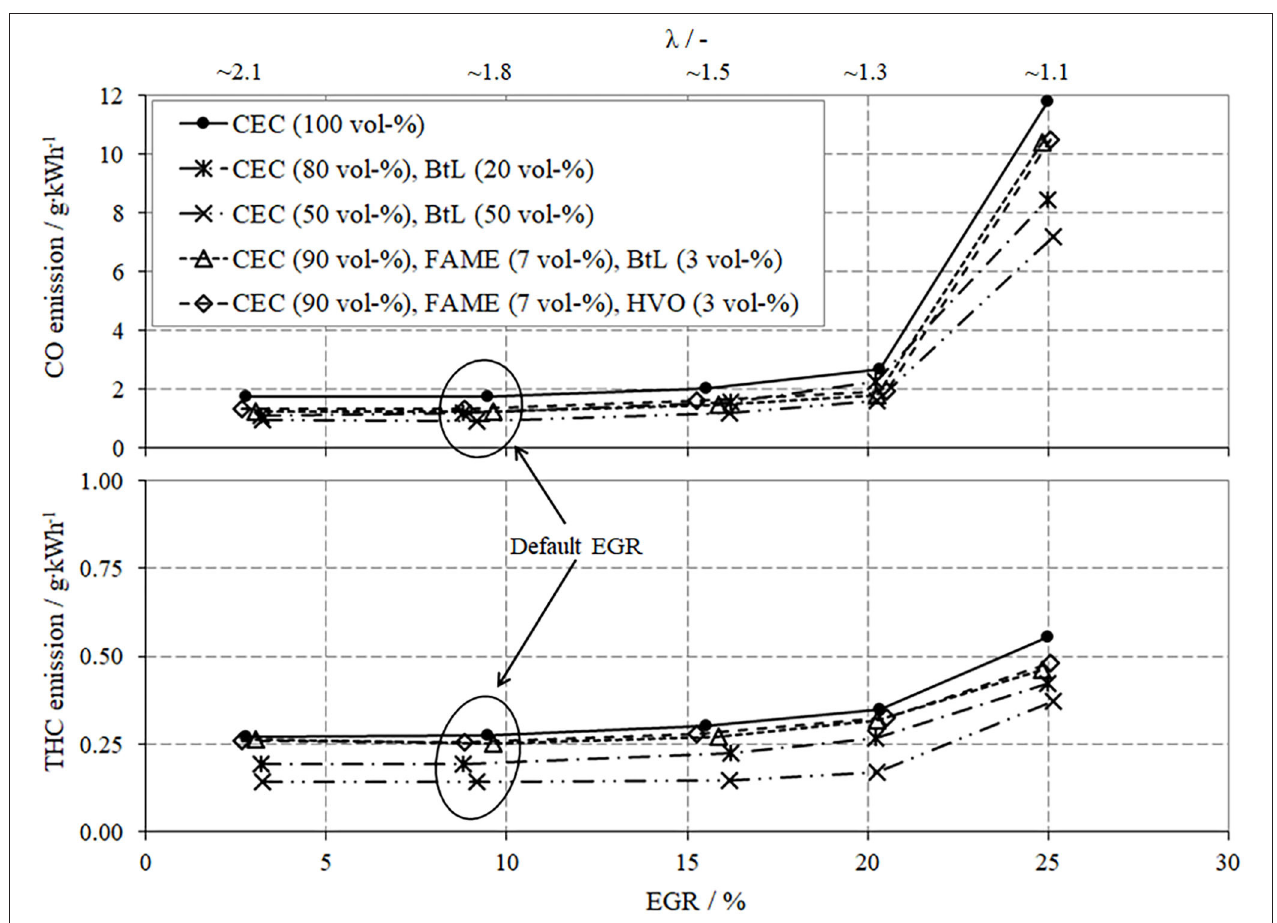
FIGURE 6 | Specific CO- and THC-emissions at 1,500 min − 1 and 5 bar BMEP with varying